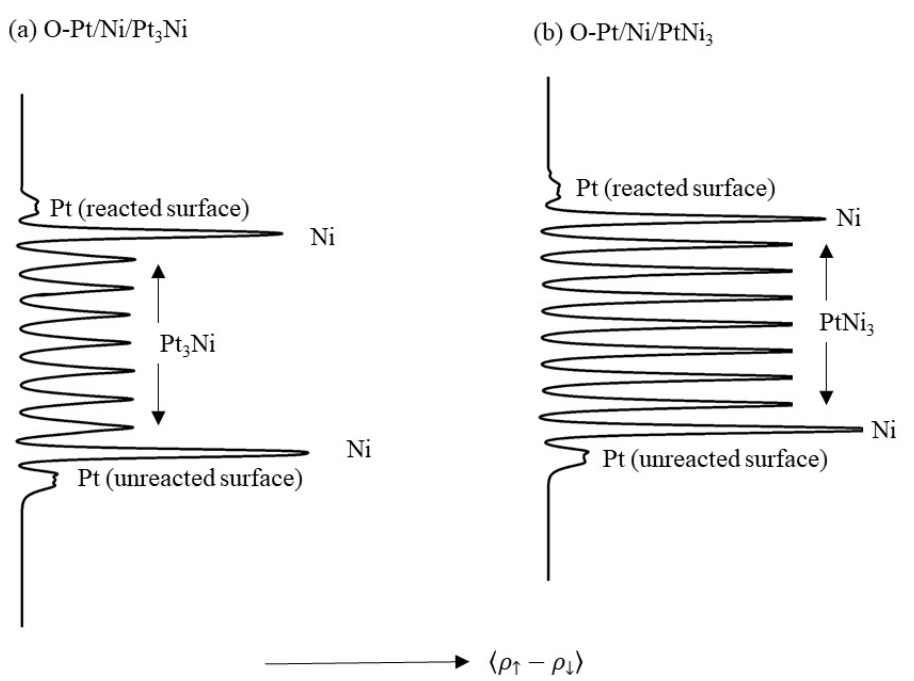
Figure 15. Average spin density ρ ↑ − ρ ↓ of the surfaces of ( a ) O-Pt/Ni/Pt 3 Ni(111) and ( b ) O- Pt/Ni/PtNi 3 (111). The oxygen atoms are bound in the FCC ‘A’ (‘FA’) sites defined in Figure 14 in the upper ‘reacted’ surfaces, whilst the lower surface is unreacted. This asymmetry is simply intended to highlight the change in the magnetic character of the respective surface Pt layers during adsorption, and quantitative results from these simulations were not subsequently used in this work. The averaging was performed parallel to the (111) plane. The labels show the regions of bulk Pt 3 Ni and PtNi 3 , selvedge Ni and surface Pt.